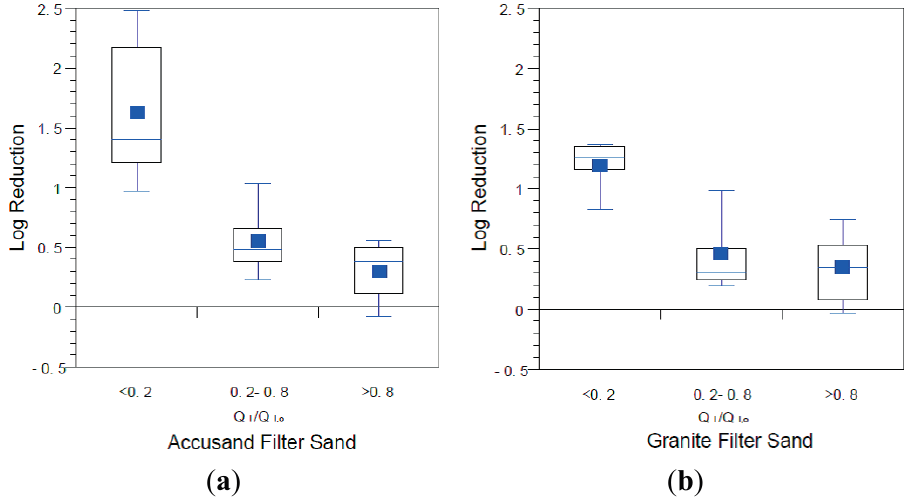
Figure 14. PRD-1 reductions for ( a ) Accusand media columns and ( b ) granite media columns in Column Tests No. 2 organized by bins of normalized filtration rate where Q I is the initial daily filtration rate on each day of charging the column and Q I,o is the initial filtration rate on the first day. N for Accusand: 6 for <0.2, 10 for 0.2–0.8, 9 for >0.8. N for granite: 6 for <0.2, 15 for 0.2–0.8, 6 for